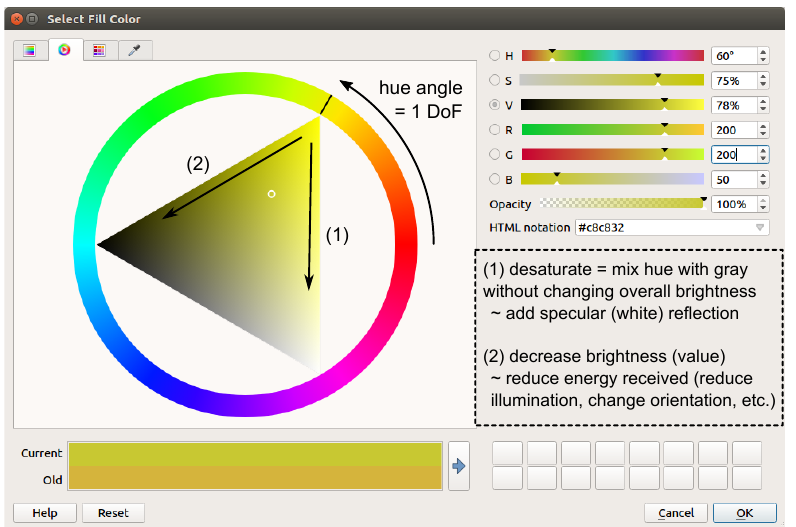
Figure 2. Screenshot of the color wheel tool in QGIS. The hue or ‘pure color’ is selected along the circle with a single angular degree of freedom (DoF). The two other operations that can be performed are (1) desaturation or (2) decrease in